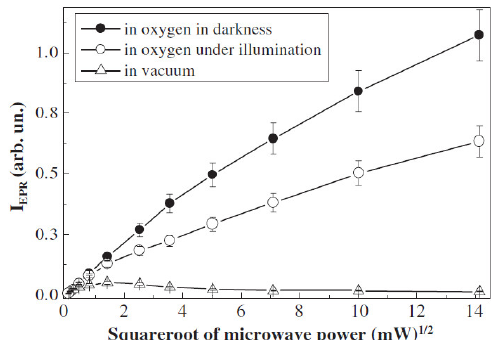
Figure 33. Dependences of the EPR signals of por-Si in vacuum (triangles) and in oxygen ambient ( P ox = 760 Torr) in darkness (solid circles) and under illumination (open circles). (Reprinted from Reference [84] with permission from Elsevier).